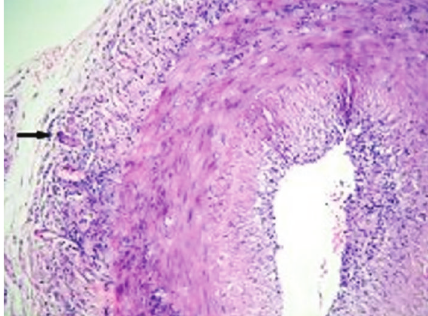
Figure 1: Mononuclear inflammatory cell infiltration in temporal artery from intima to the adventitia layer (HE ,×10 ).